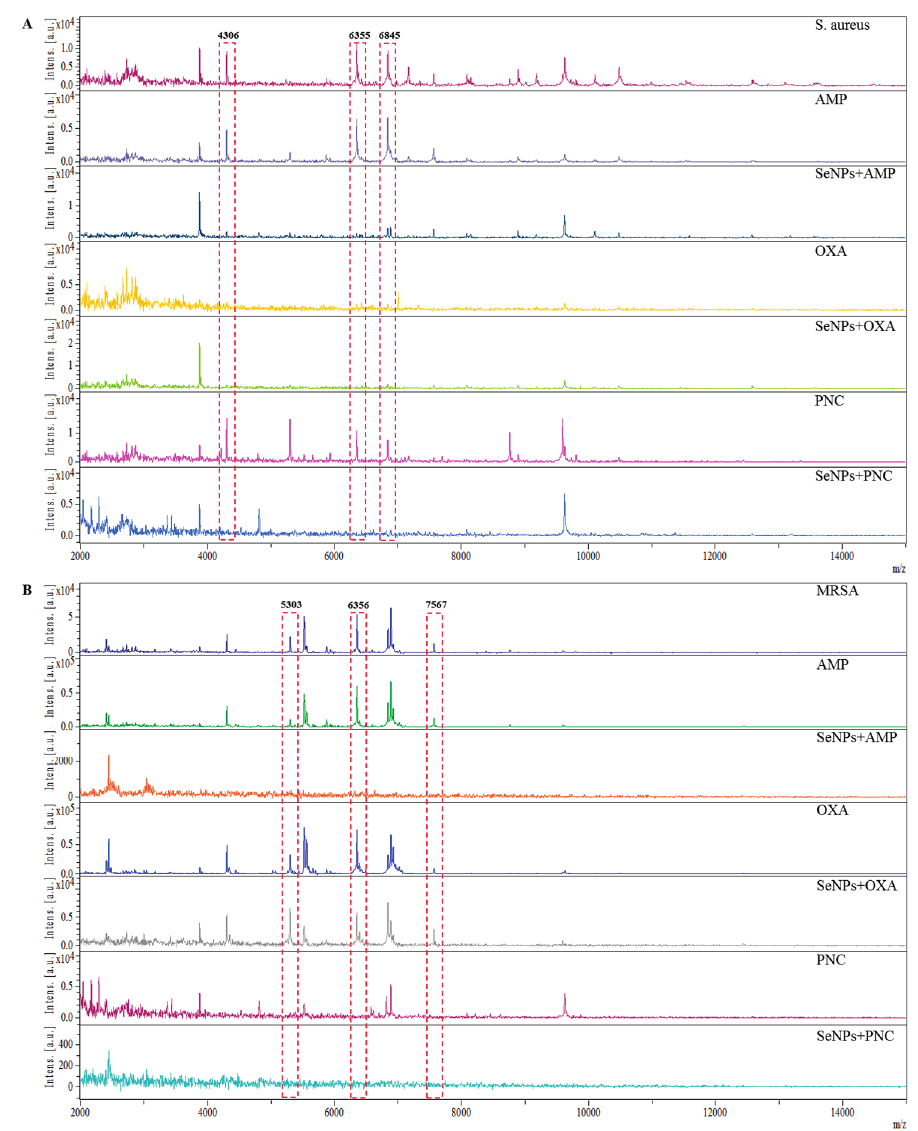
Figure 4. The comparison of MALDI-TOF mass spectra of ( A ) S. aureus and ( B ) MRSA with ampicillin, SeNPs with ampicillin, oxacillin, SeNPs with oxacillin, penicillin and SeNPs with penicillin. The analysis was performed in linear positive mode. A solution of 2,5-dihydroxybenzoic acid (concentration 20 mg·mL − 1 ) in 30% acetonitrile and 0%, 1% trifluoroacetic acid was used as a matrix. The laser power was set to 75%. The highlighted peaks show the biggest differences in compared